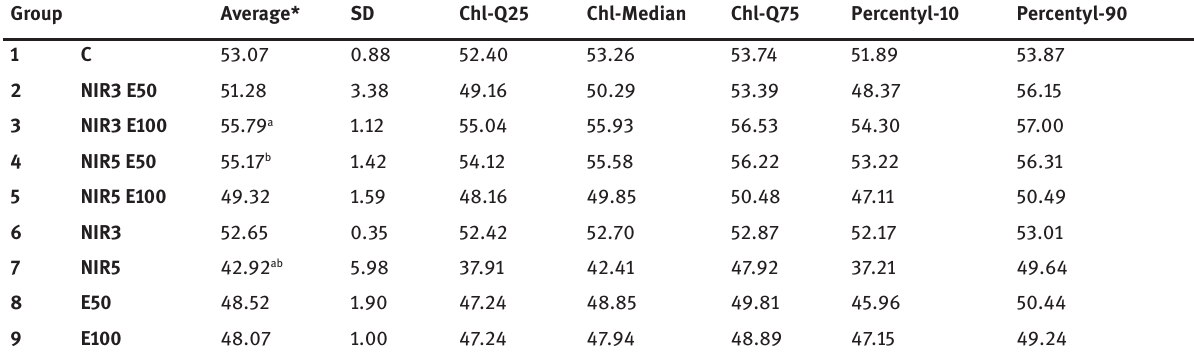
Table 3: Descriptive statistics for the measurements of chlorophyll by SPAD method in the normal seedlings of soybean. Group